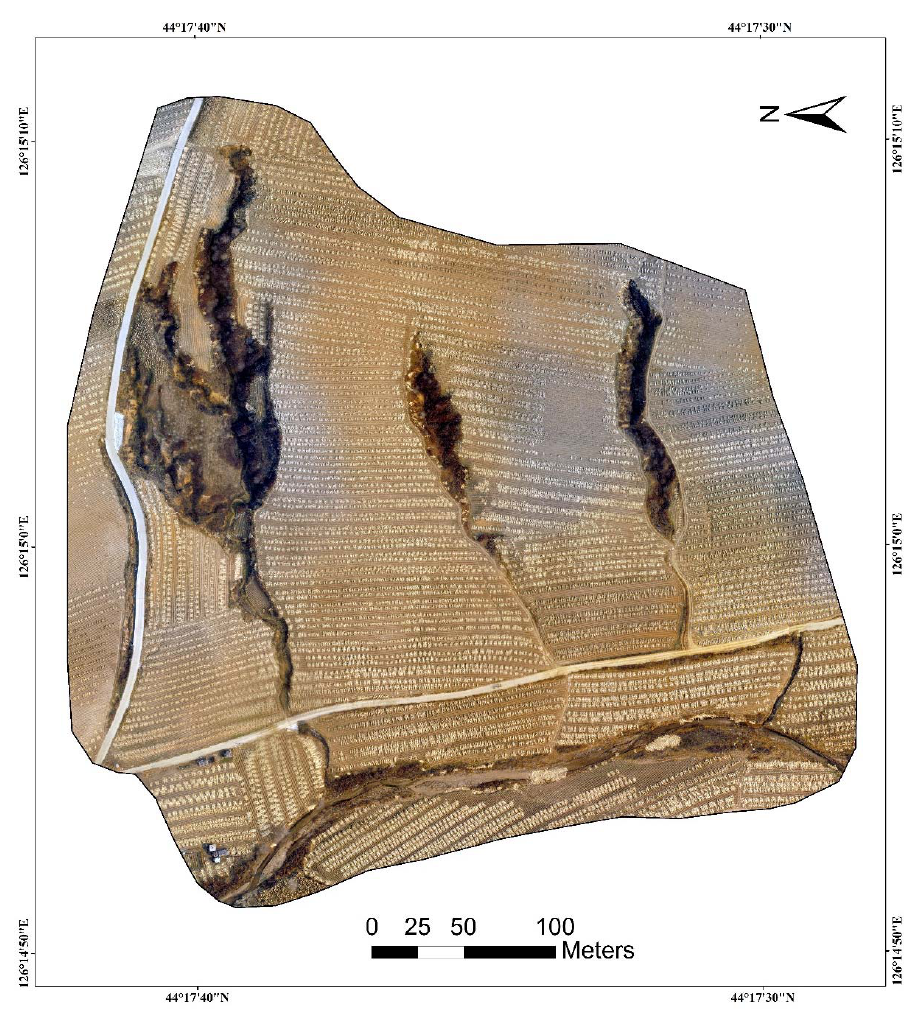
Table 4. Summary of the outputs obtained in Pix4dmapper.